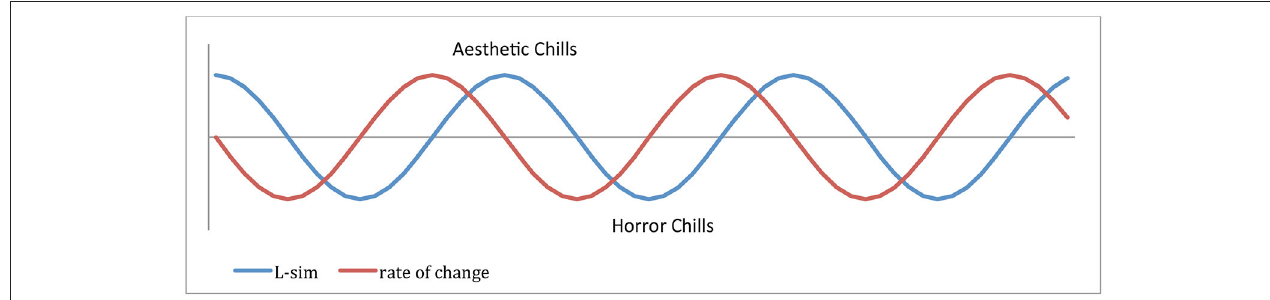
FIGURE 1 | Notional illustration of KI changes. Satisfaction of KI, aesthetic chills, corresponds to max L , and L ′ = 0; dissatisfaction of KI, horror chills, corresponds to min L , and L ′ = 0. Vertical axis is Similarity L and horizontal axis is Time in arbitrary units.